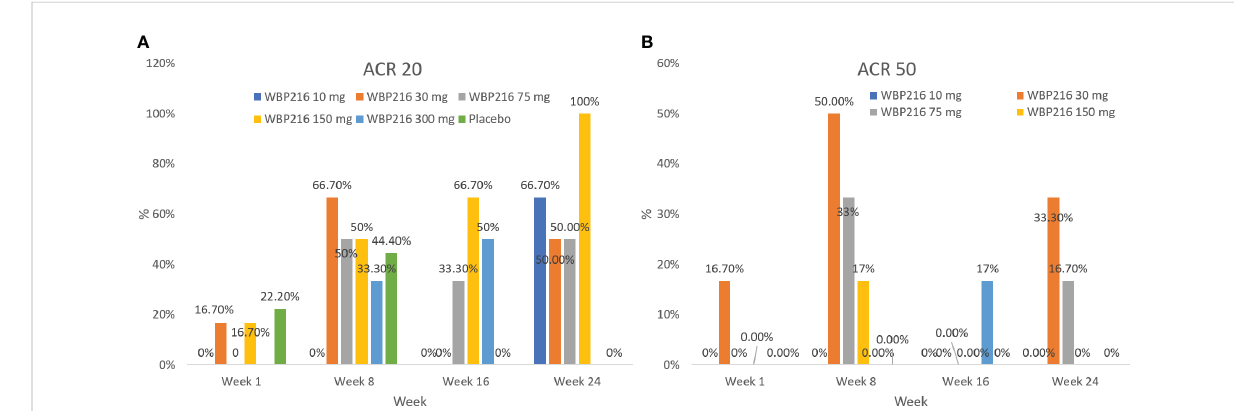
FIGURE 4 (A) ACR20 response rate in each cohort: ef fi cacy analysis set; (B) ACR50 response rate in each cohort: ef fi cacy analysis set ACR, American College of Rheumatology; DAS28, Disease Activity Score 28-joint assessment.